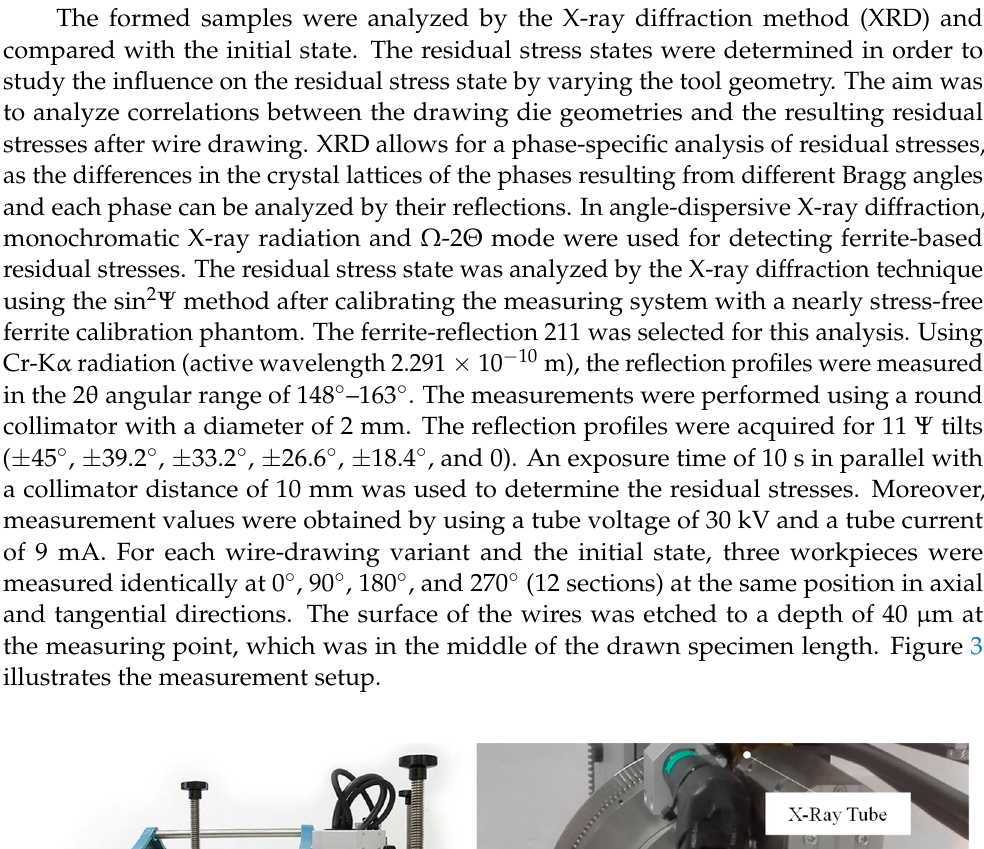
Figure 3. XRD analysis—basic system and measurement setup for wire workpiece. Flow curves were produced for material S355 for the FE simulation of the wire-draw- ing process. The specimens (D = 5 mm, height = 10 mm) were manufactured from the same rod material as the drawing specimens. The compression test’s strain rate of the three